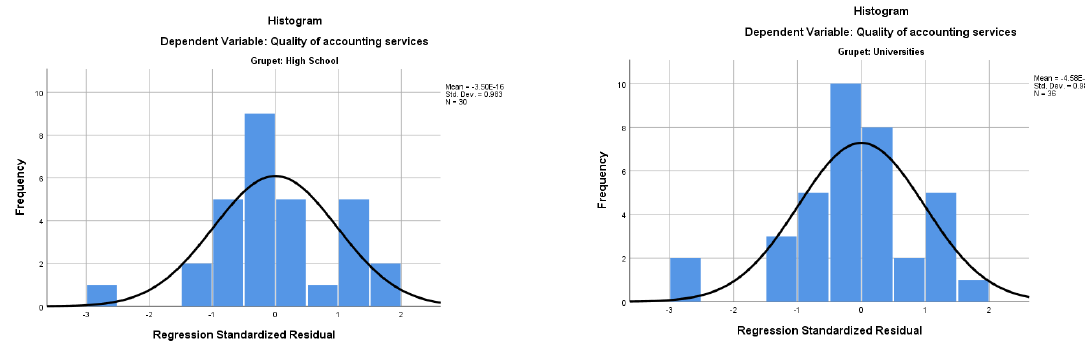
Fig. 4. The results of residuals for the regression analysis